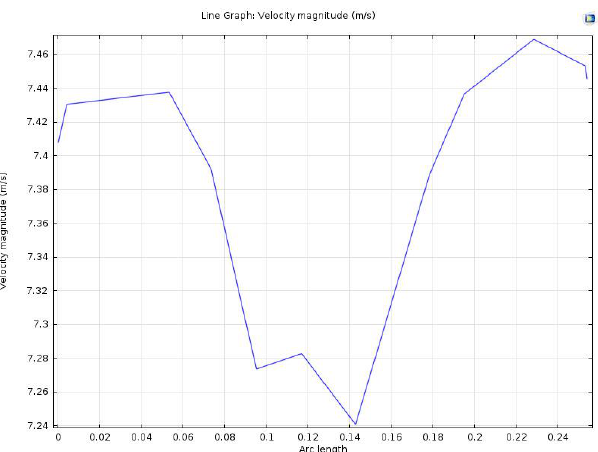
Figure 7. Air flow velocity graph at the location of closed-type wind turbine blades The results of the calculations performed for various options at an initial wind speed from 5 m/s to 40 m/s are shown in Table